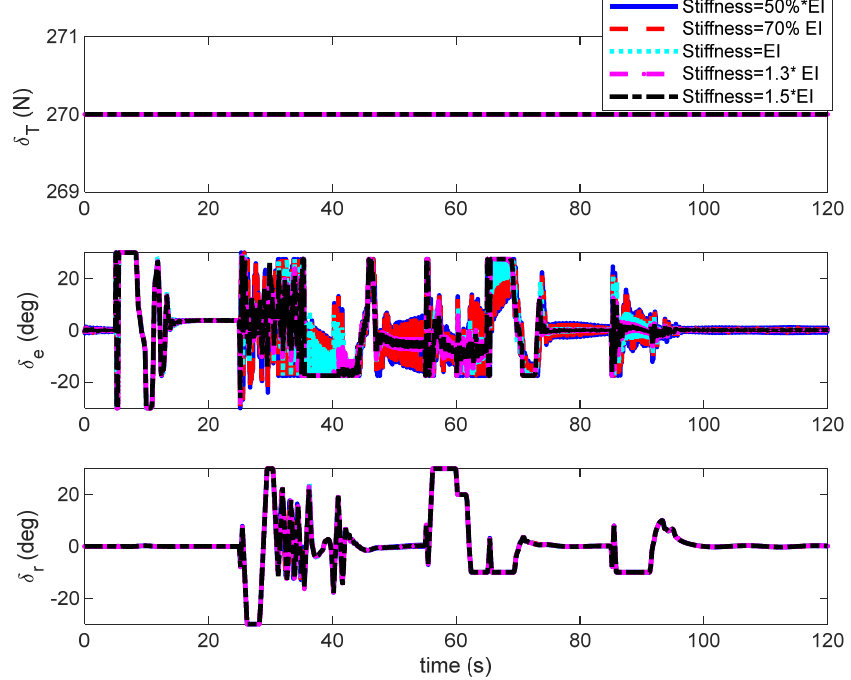
Figure 16. Control inputs with five stiffness variants.